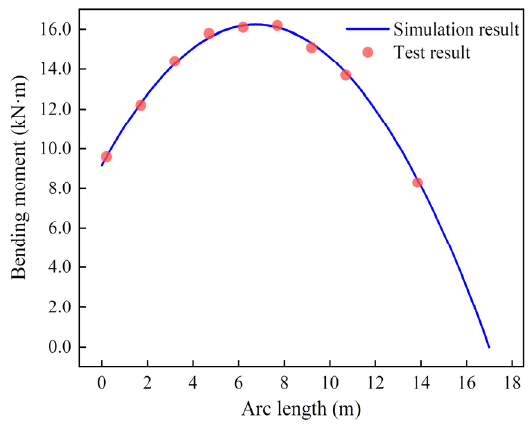
Figure 24. Distribution of bending moment of the model SCR.